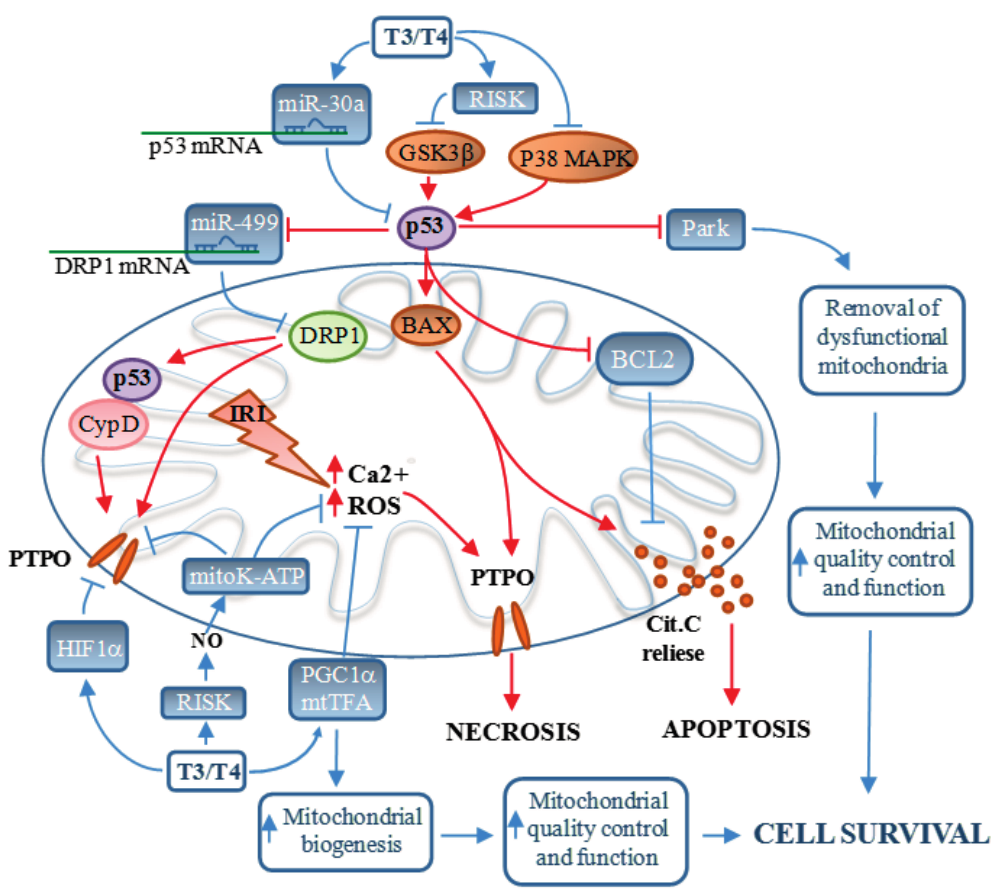
Figure 1. Schematic overview of the role of TH in the modulation of the mitochondrial pro-survival (blue connectors) or pro-death (red connectors) signaling networks that control cardiomyocyte fate in the I/R heart. CypD = Cyclophilin D; DRP1 = dynamin-related protein 1; GSK3 β = glycogen synthase kinase 3- β ; HIF1 α = Hypoxia inducible factor 1 α , IRI = ischemia/reperfusion injuries; mitoK-ATP = mitochondrial ATP-dependent potassium channel; mtTFA = mitochondrial transcription factor A; Park = parkin; PTPO = permeability transition pore opening; PGC1- α = peroxisome proliferator-activated receptor- γ coactivator-1 α ; RISK = reperfusion injury salvage